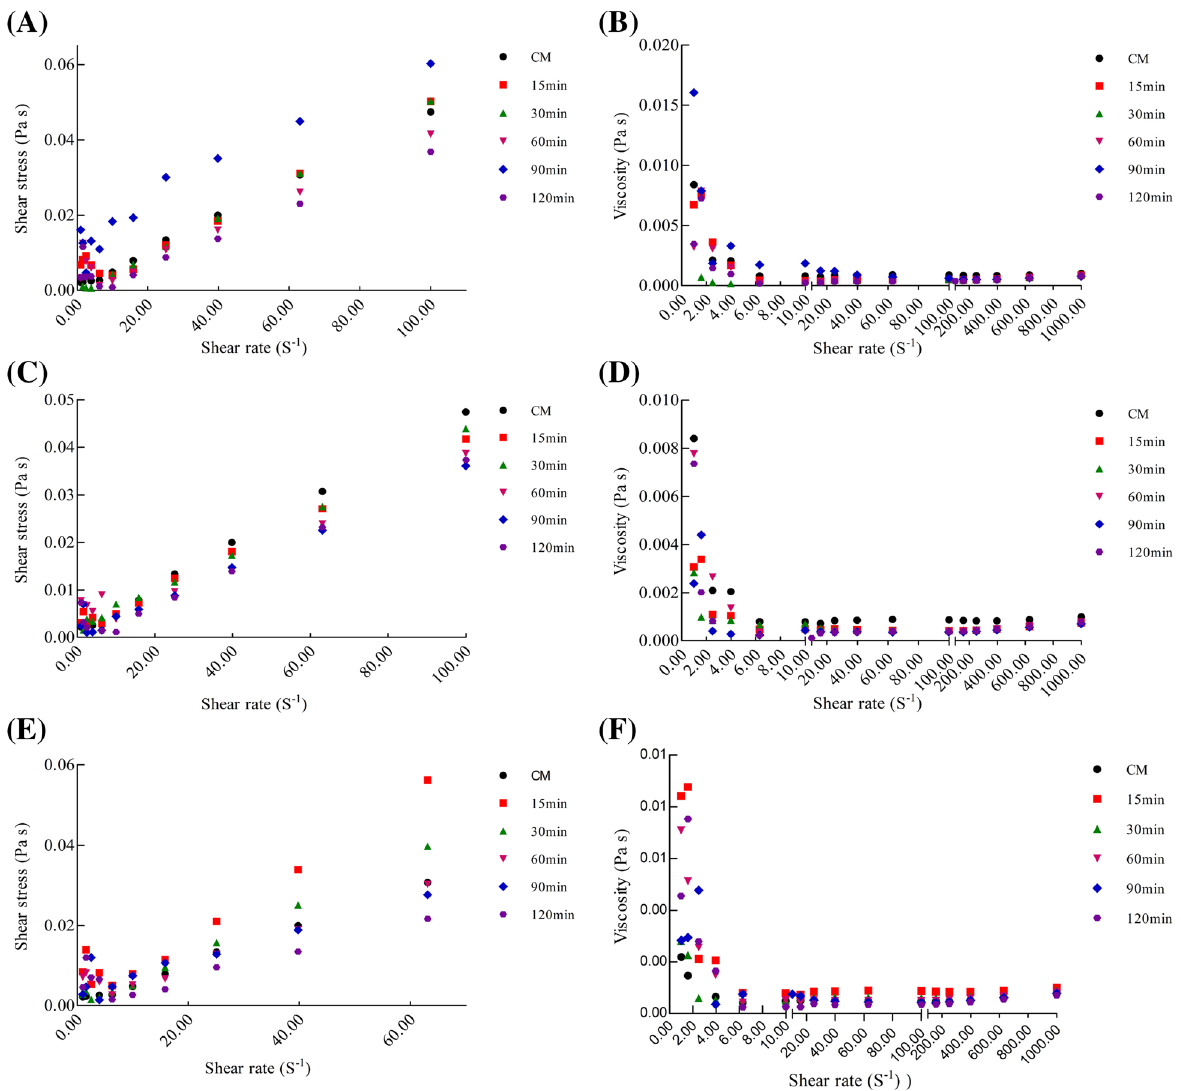
Figure 12. The shear stress and viscosity of CM, AT ( A , B ), PT ( C , D ) and FT ( E , F ). Alcalase-treated cow milk (AT), Protamex-treated cow milk (PT), Flavourzyme-treated cow milk